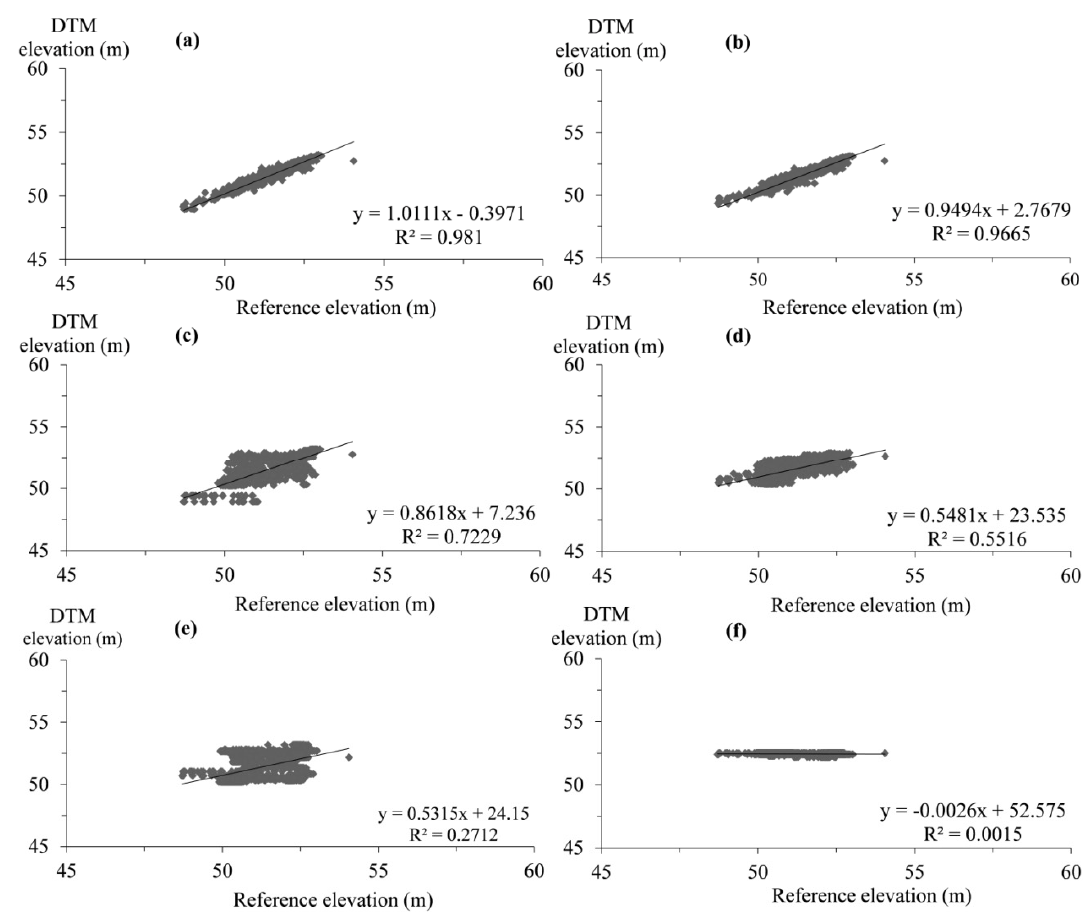
Figure 5. Scatter plots of reference data versus DTM elevations in reference area